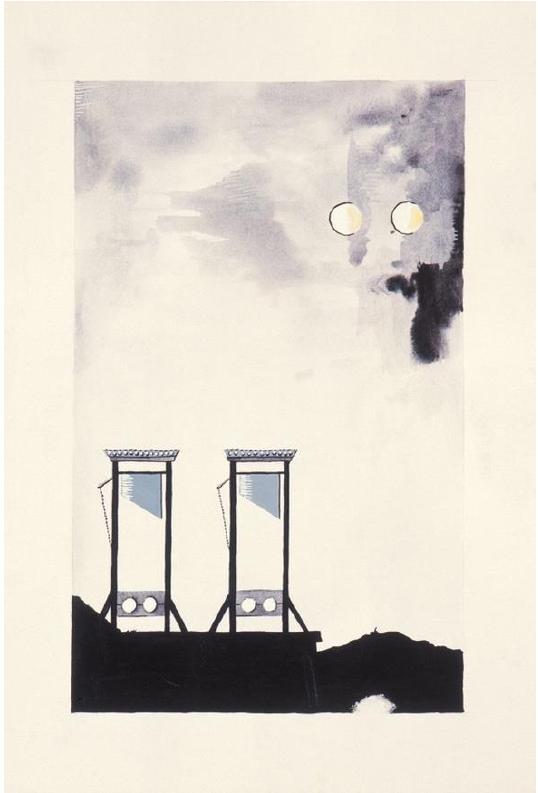
Figure 24. Justine Frank, Double Double Guillotine , 1936, gouache on paper, 50 × 35 cm. Courtesy of the artist.